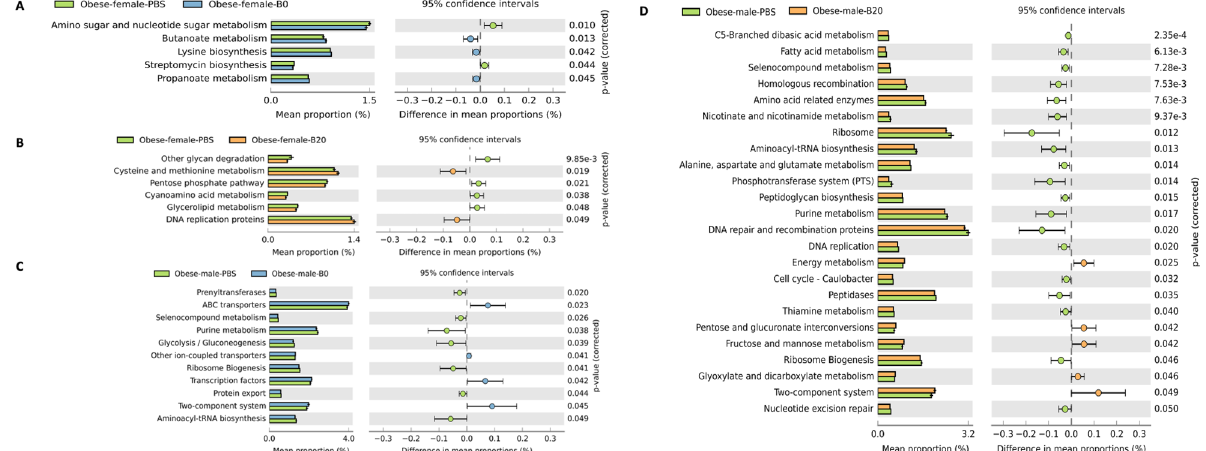
Figure 2. The difference in mean proportion of microbial function between ( A ) female PBS and B0; ( B ) female PBS and B20; ( C ) male PBS and B0 and ( D ) male PBS and B20 along with the associated 95% confidence interval of this effect size and the p value less than